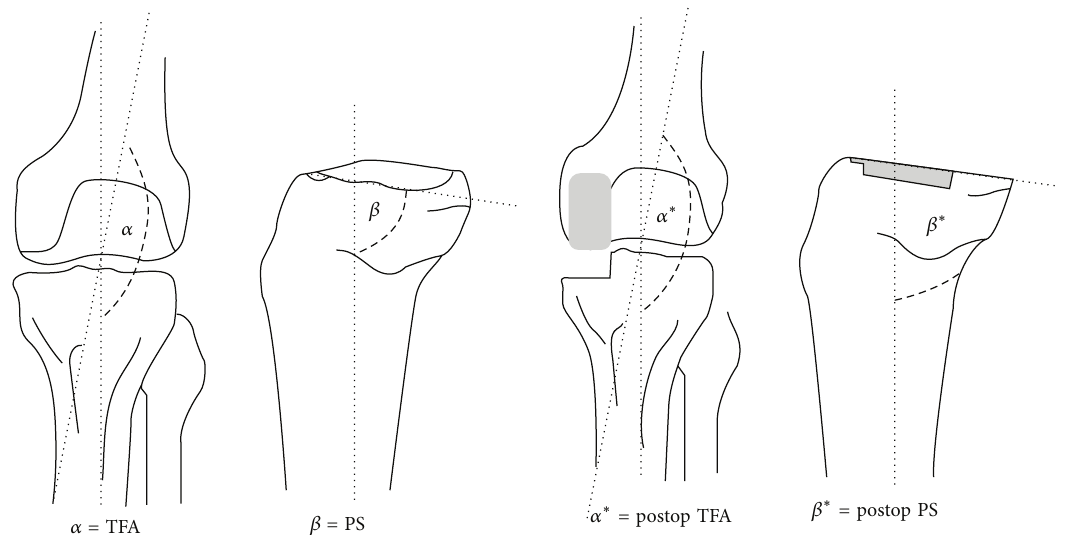
Figure 1: The femorotibial angle (FTA, 𝛼 ) formed by the intersection of the anatomical femoral and tibial axes. The tibial posterior slope angle (PS, 𝛽 ) was evaluated in preoperative lateral radiographs by considering the intersection of a line perpendicular to the articular surface of the medial tibial plateau and the anatomical mediolateral axis (i.e., the line between points situated at 10 and 20 cm from the plateau and located midway between the two cortices). In postoperative radiographs, it was determined as the angle formed by the intersection of the anatomical tibial axis and the horizontal axis of the tibial component